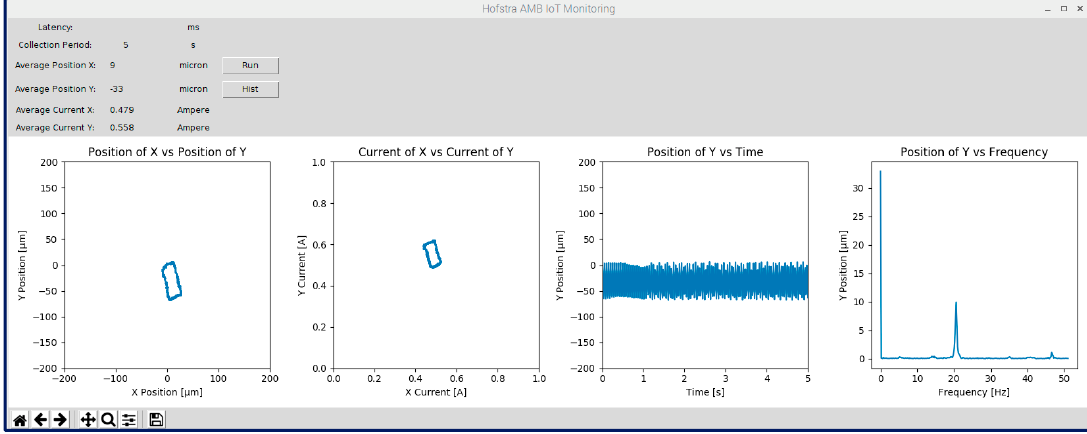
Figure 11. AMB IoT condition monitoring GUI display for rotating shaft with two collars and dynamic unbalance.